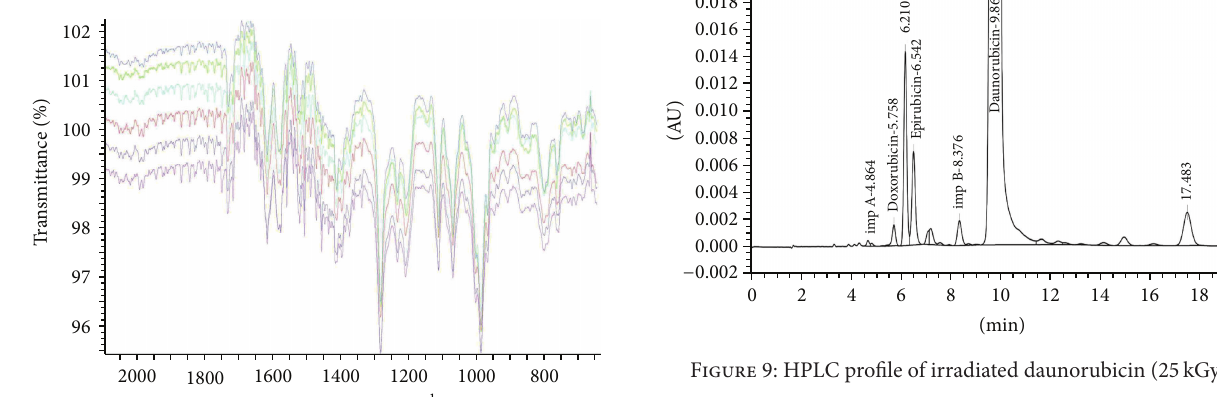
performed at 254 nm. The flow rate was 1.0 mL/min. The injected volume was 5 𝜇